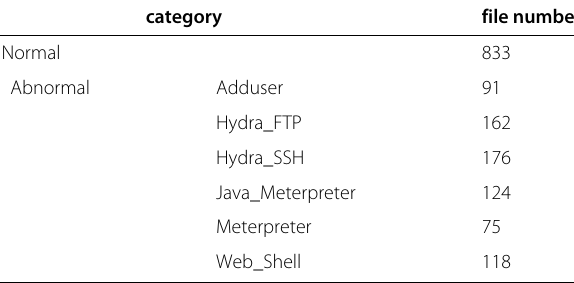
Table 4 The ADFA-LD